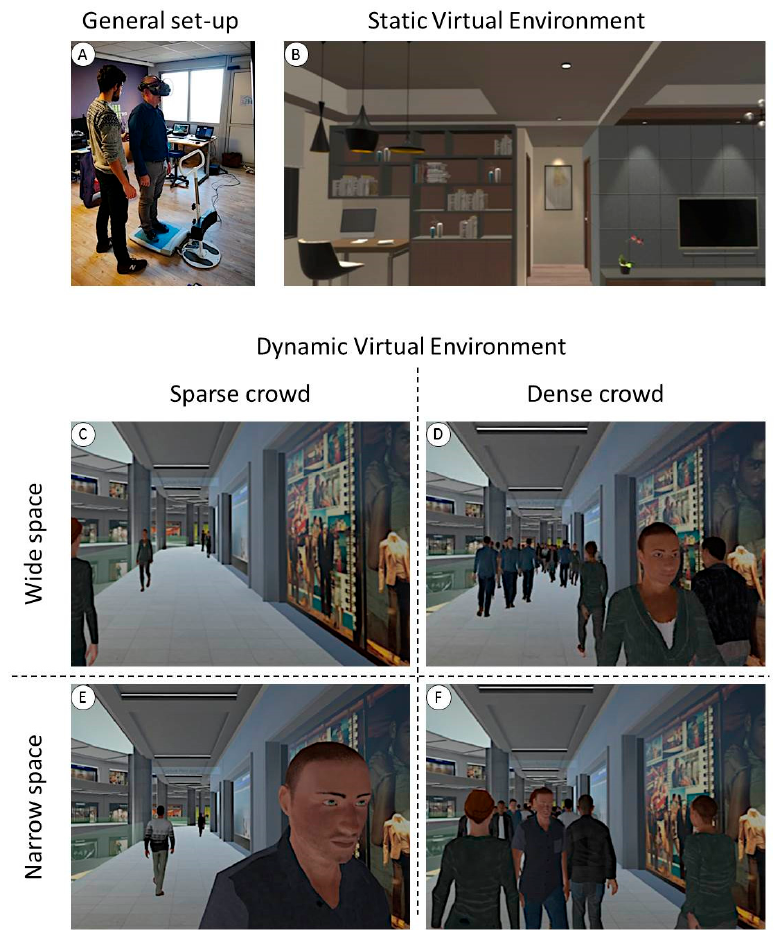
Figure 1. General experimental setup ( A ), static virtual environment ( B ), and dynamic virtual environment in sparse crowd and wide space ( C ), dense crowd and wide space ( D ), sparse crowd and narrow space ( E ), and dense crowd and narrow space ( F ) conditions.